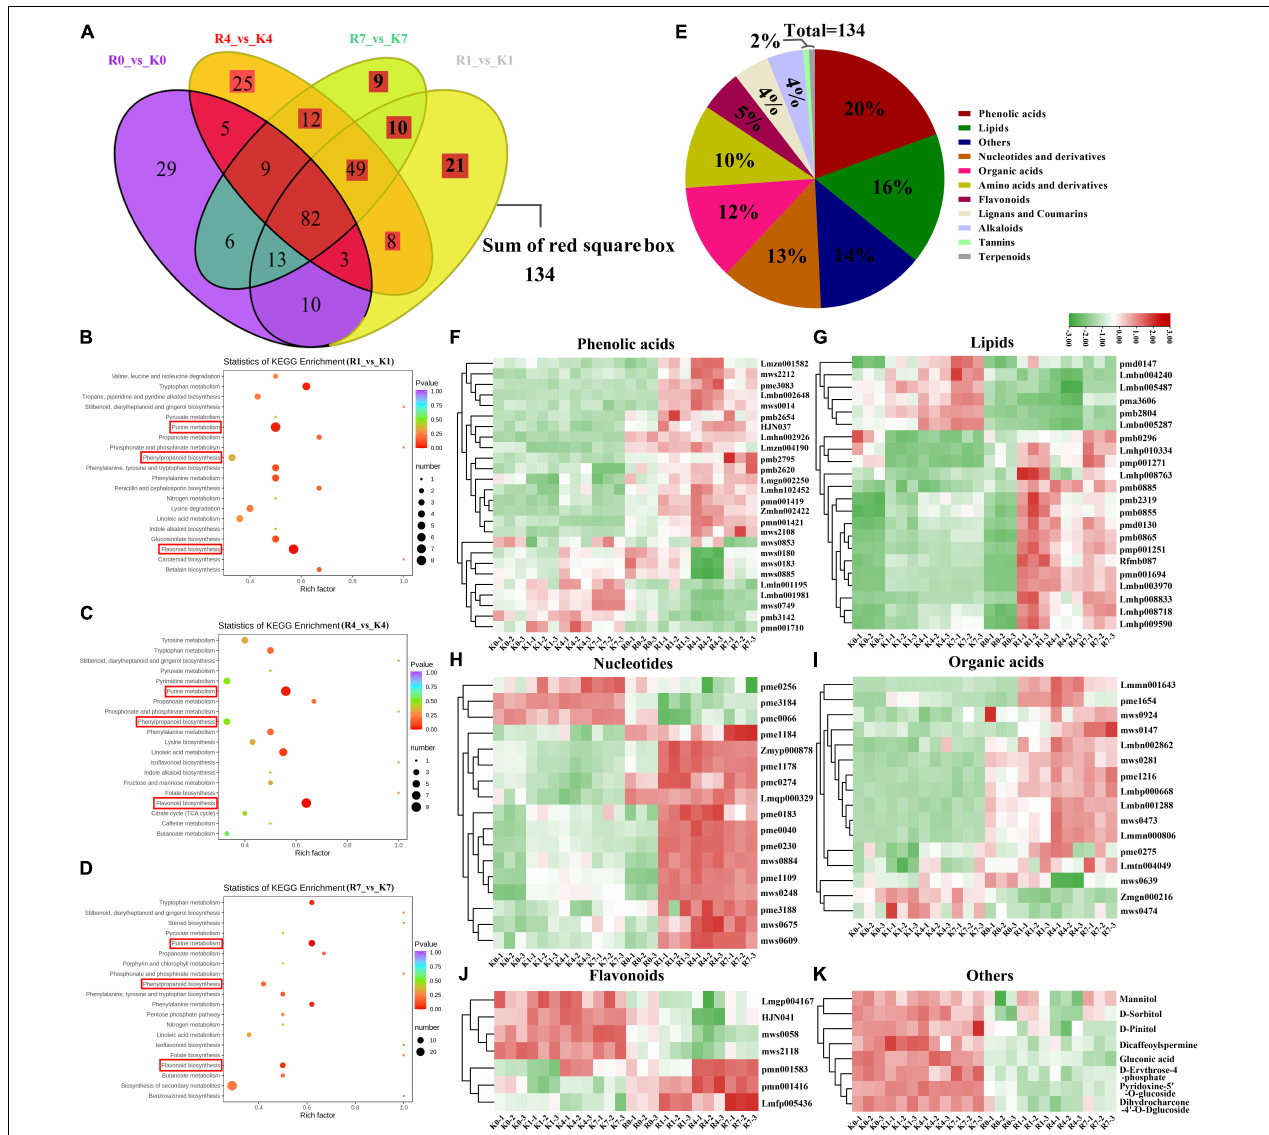
FIGURE 5 | Comparison of the DEMs between KL and RB under the freezing condition. (A) Venn diagrams of DEMs of KL and RB at different treatment time points. (B–D) KEGG pathway enrichment of DEMs at different treatment time points. (E) Classification of the 134 specific under cold stress. (F–K) Heat map of metabolite responsive to cold in both KL and